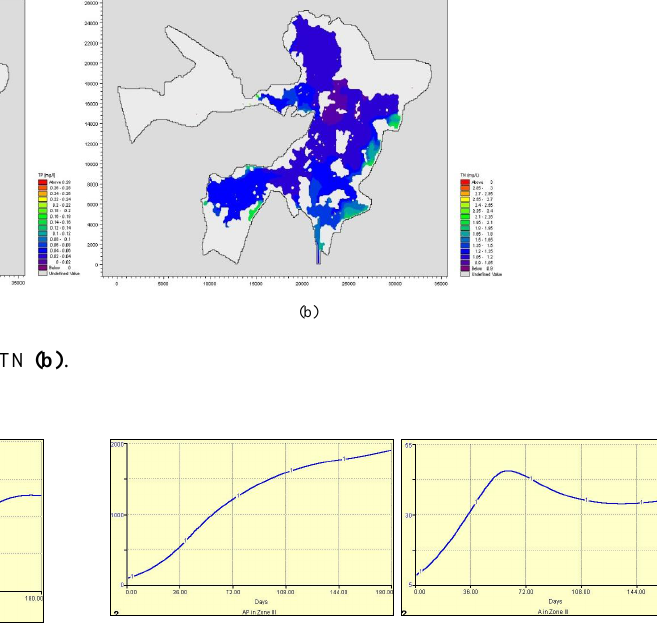
Fig. 20. Simulation results of the main ecological indexes at zone I